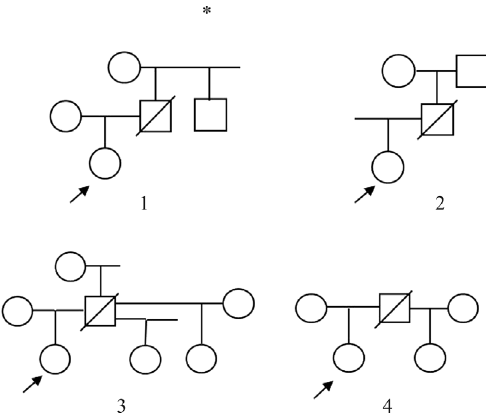
Figure 1 - Pedigrees of the four deficiency paternity cases.